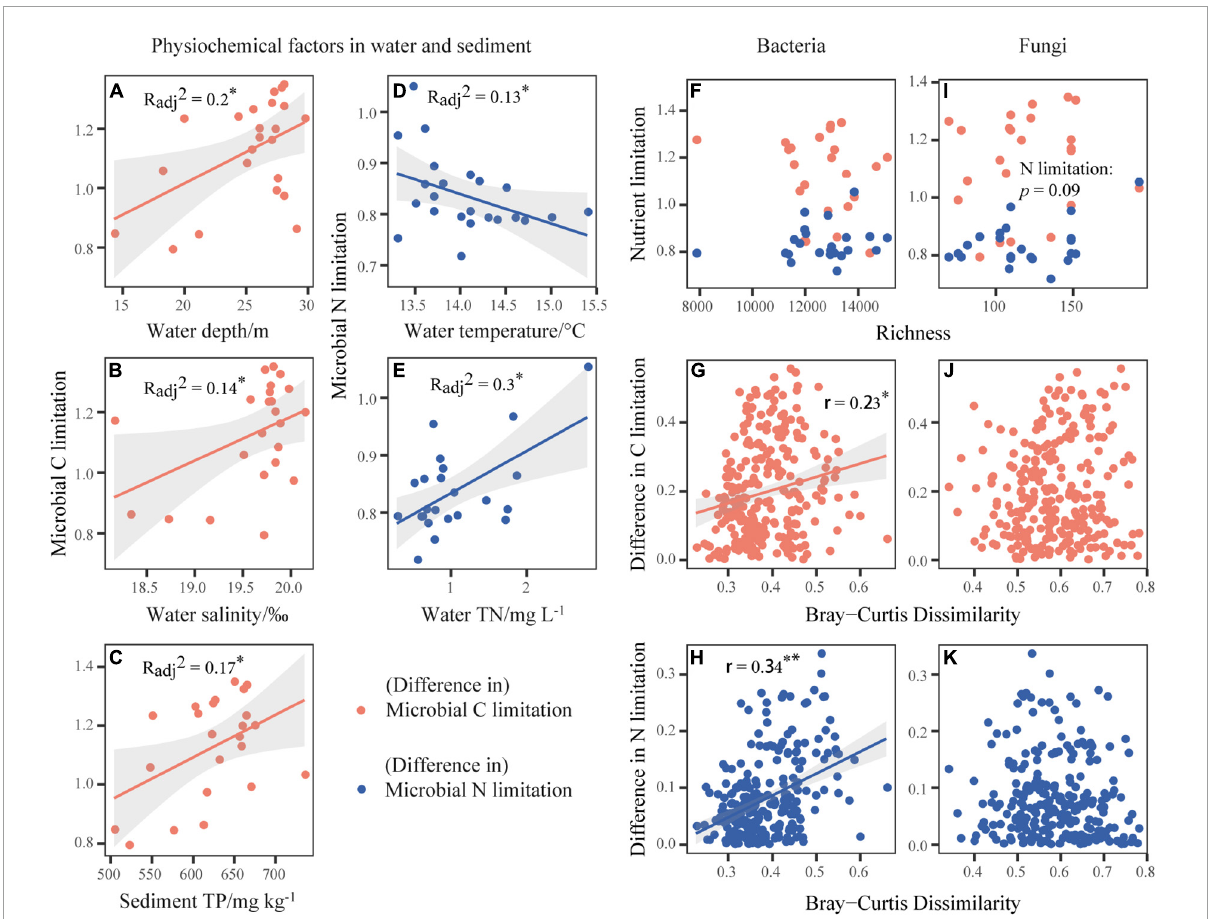
FIGURE2 Correlations of the microbial metabolic limitations with physiochemical factors in water and sediment (A–E) or bacterial and fungal community richness (F,I) . And the relationships between bacterial (G,H) or fungal (J,K) community composition represented by Bray-Curtis dissimilarity and difference in microbial metabolic limitations. The orange dot indicates the vertical axis variable as microbial C limitation or difference in microbial C limitation. The blue dot indicates the vertical axis variable as microbial N limitation or difference in microbial N limitation. The lines represent the fitted linear regressions with 95% confidence intervals indicated by the shaded areas, where only significant relationships are shown. The adjusted R 2 or r values of the linear models are denoted. *p < 0.05, **p <